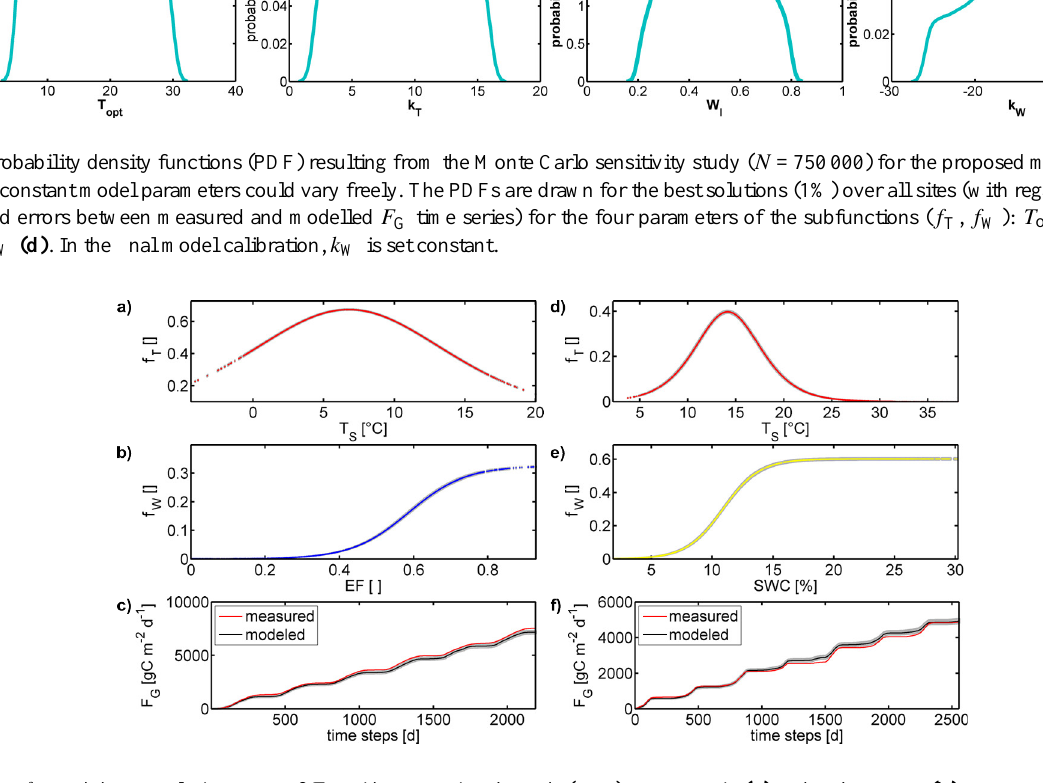
Fig. 7. f T , f W and the cumulative sums of F G with uncertainty bounds (grey) at Wetzstein (a) and Duke Forest (b) . EF was used to model F G in (a) and SWC in (b) as water availability measure. The 95% uncertainty bounds are due to the propagation of uncertainties in associated parameter estimates, as obtained by a Monte-Carlo simulation ( N =1000); see text for further